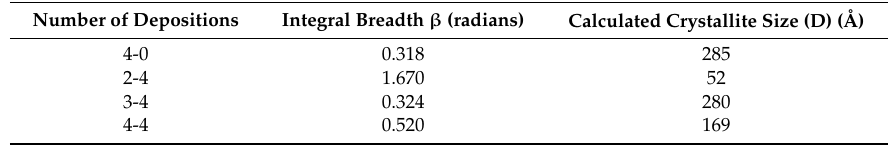
Table 9. Integral breadth values and calculated values of the crystallite size of the (111) nickel peak as a function of the number of